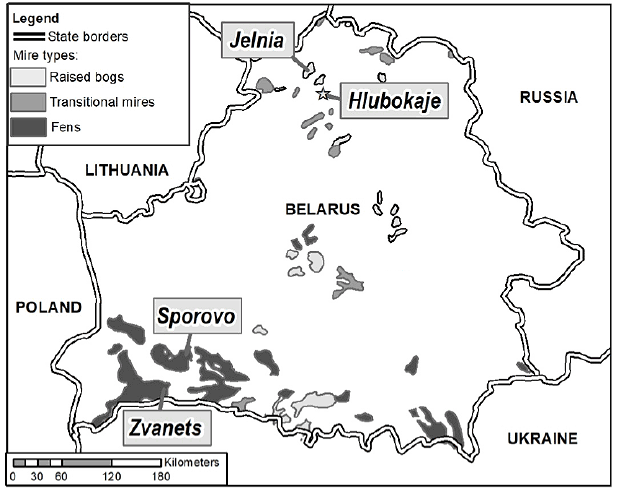
Fig. 2 . Case study locations. Locations of bogs and mires extracted from Bohn et al. (2000).